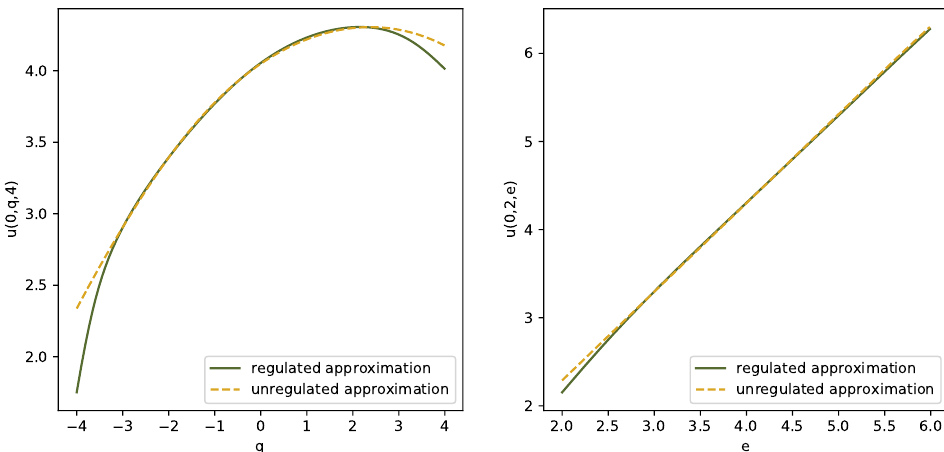
Figure 8. DNN-approximations of u reg ( 0, q , e ) ( green ) and u unreg ( 0, q , e ) ( orange ) on the section { ( q ,4 ) : q ∈ [ − 4,4 ] } ( left ) and on { ( 2, e ) : e ∈ [ 2,6 ] } ( right